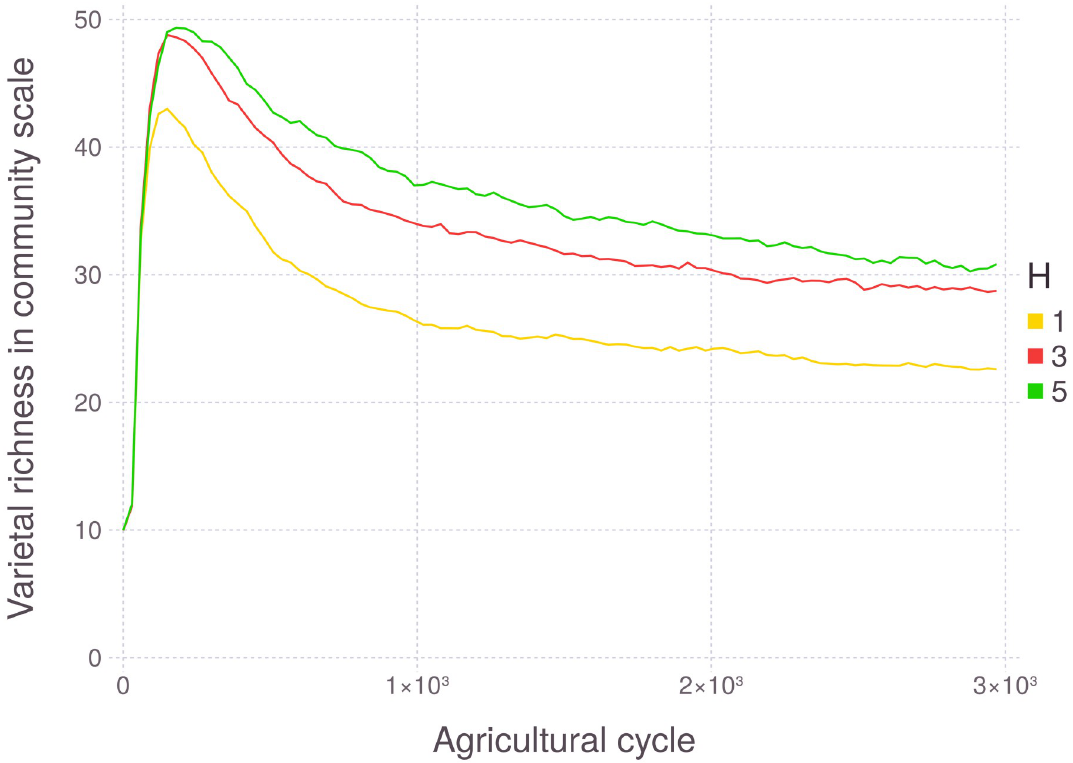
Fig 5. Evolution of varietal richness at the community level, with varying resource heterogeneity (H). H = 1 means there is only one set of resources in all plot fractions. Each line represents the aggregation of 200 runs.